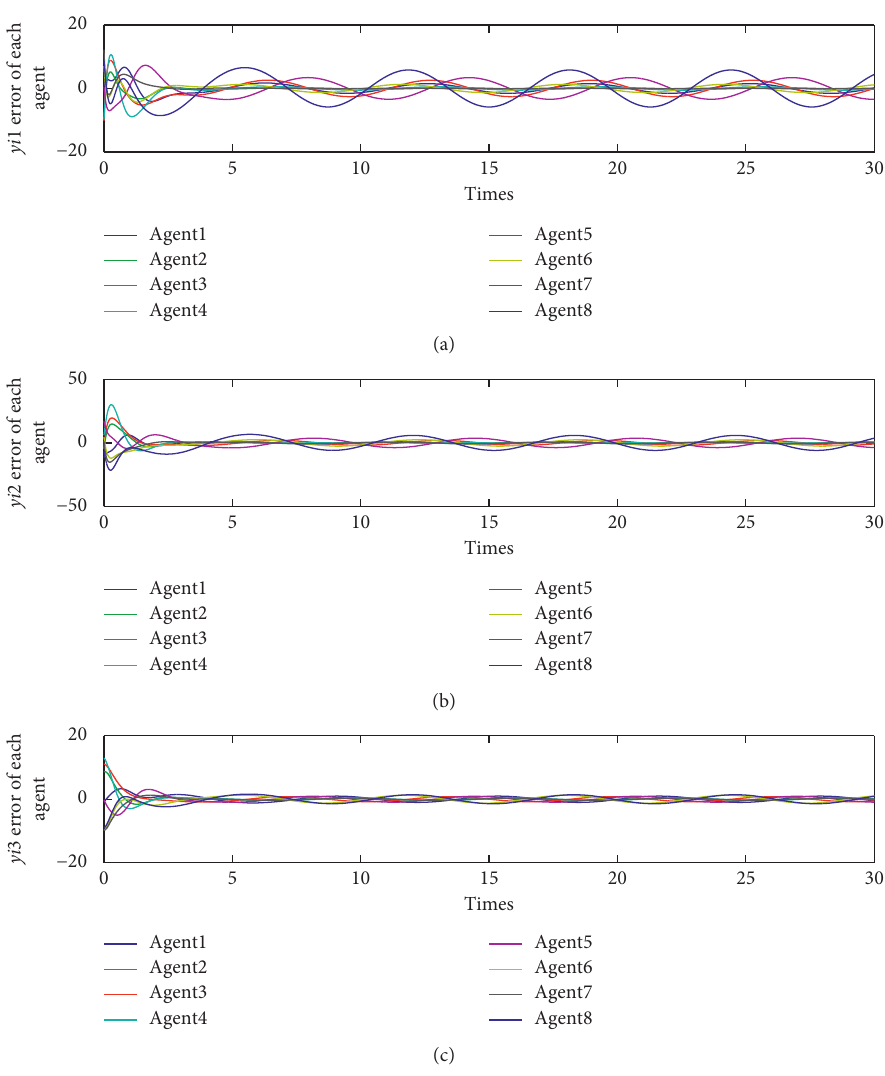
Figure 4: Output error of eight agents without the robust compensator.